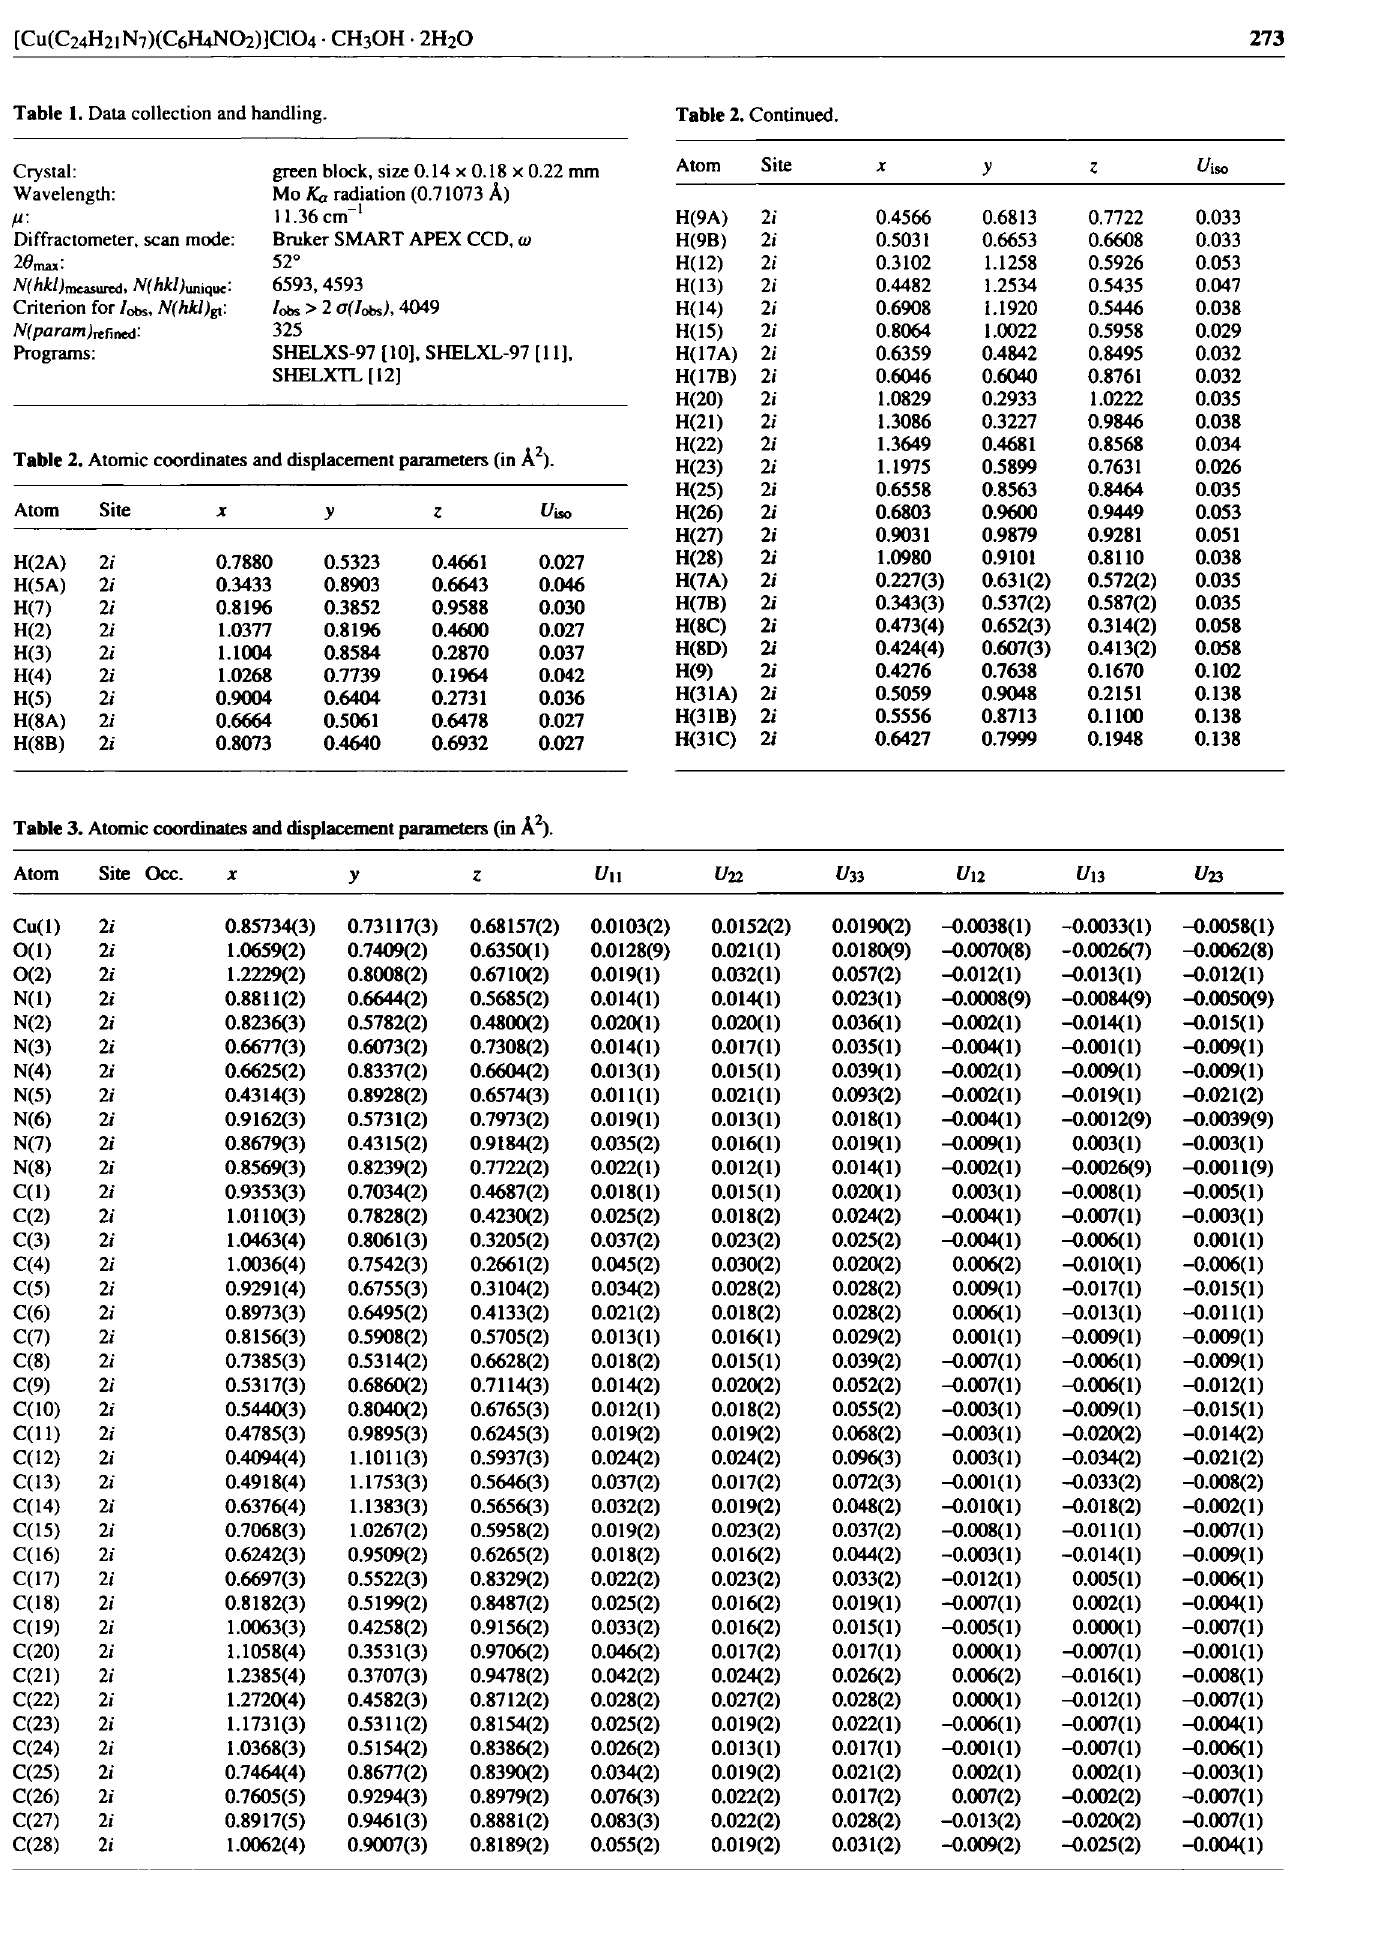
Table 1. Data collection and handling. Table 2. Continued.